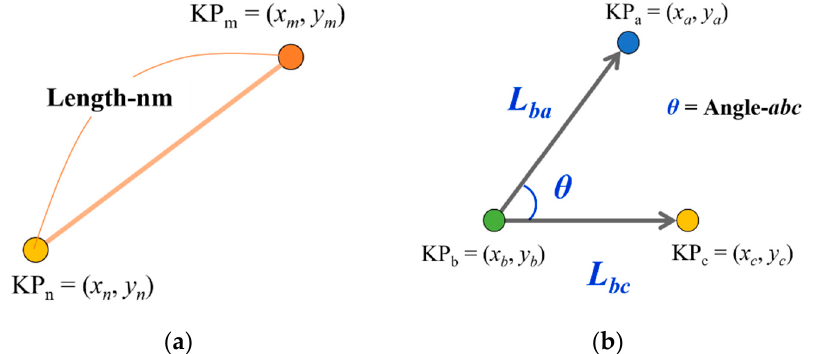
Figure 4. Calculation of the arm’s length and angle of the bending arm. ( a ) Calculation of the arm’s length from two coordinates by using the distance between two points KP n and KP m . This method is applied to calculate the length of ① , ② , ④ , ⑤ in Table 1; ( b ) Calculation of the angle of the bending arm from three coordinates which are indexed by ③ , ⑥ in Table 1 by using the inner product.